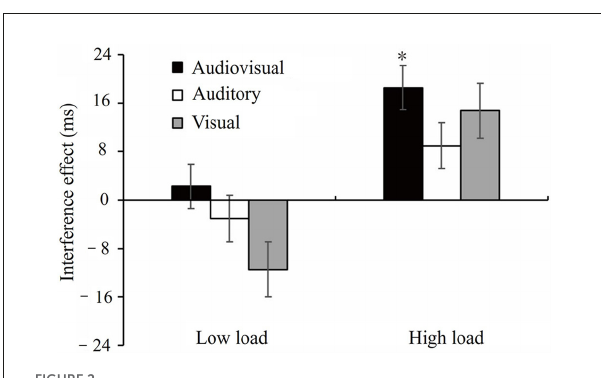
FIGURE2 Means and standard errors for the interference effect (RTs with distractors minus RTs without distractors) under auditory, visual, and audiovisual distractors conditions. The interference effect was shown under low and high working memory load, respectively. * indicates p < 0.05. RTs, reaction